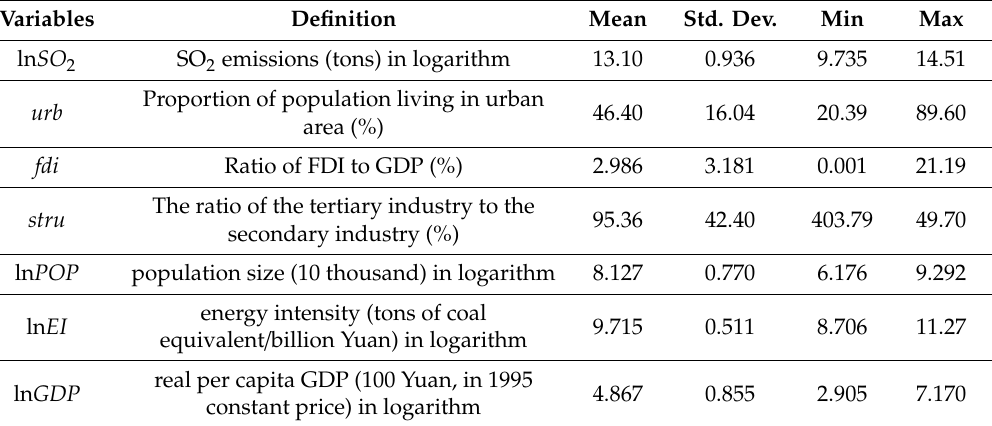
Table 1. Definitions and descriptive statistics of the